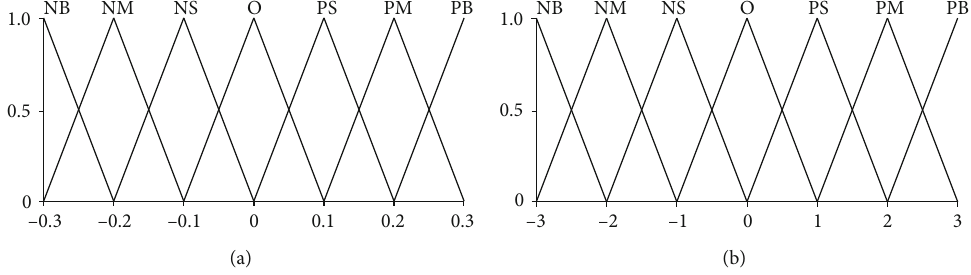
Figure 5: (a) The membership of Δ K